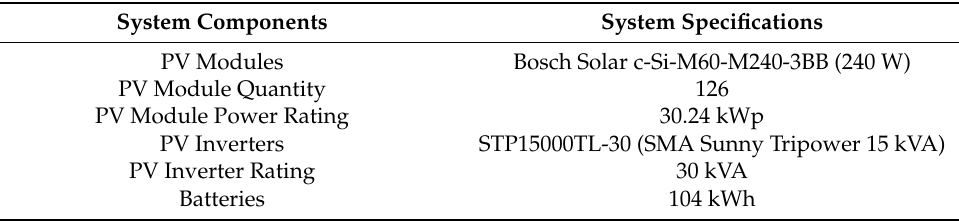
Figure 4 . Location of the case study area—Mbita, Kenya ( Lake Victoria ) [31]. Figure 4. Location of the case study area—Mbita, Kenya ( Lake Victoria ) [31]. Table 2. Detailed information on electricity generation at Mbita WeTu Hub [32–38]. Table 2. Detailed information on electricity generation at Mbita WeTu Hub